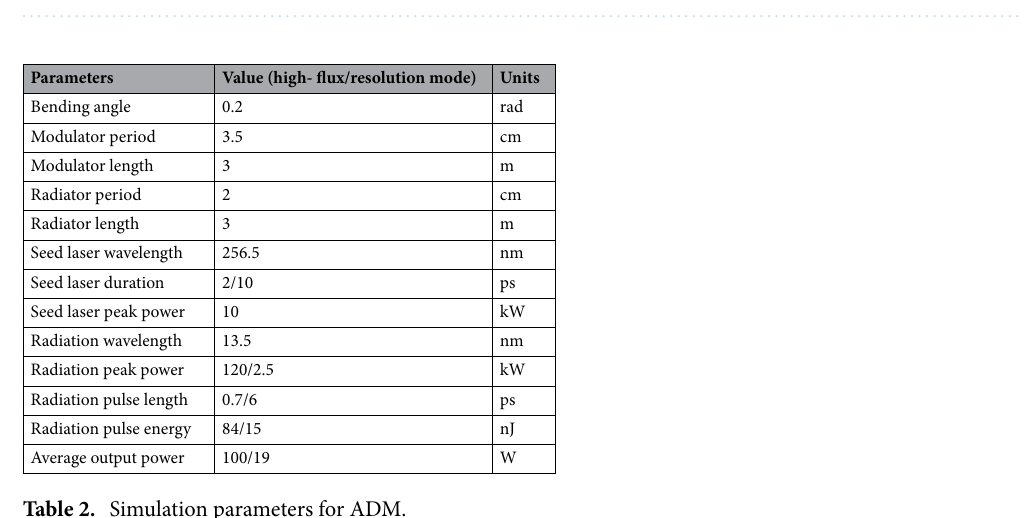
Table 2. Simulation parameters for